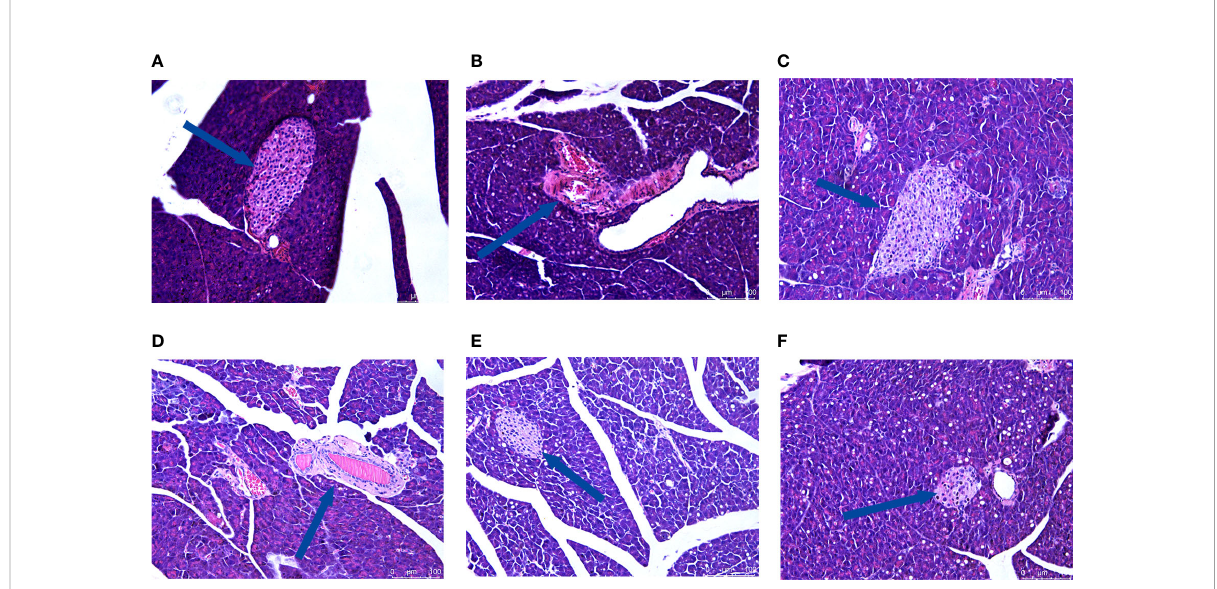
FIGURE 6 Effect of CRPR on pancreatic histopathology. Representative H&E staining of liver sections from the (A) NC, (B) MC, (C) MET, (D) CRPR-L, (E) CRPR-M, and (F) CRPR-H groups (200x magni fi